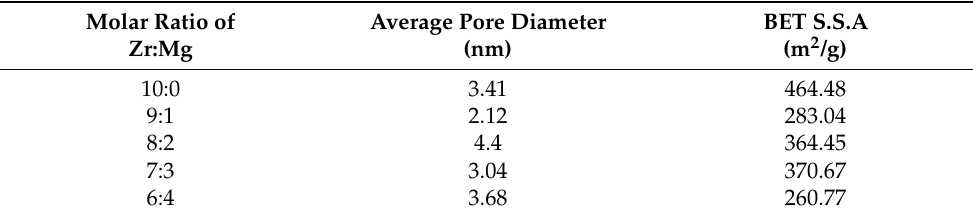
Table 1. The average pore diameter and specific surface area of the as-prepared Zr–Mg mixed oxide aerogels with different Zr/Mg molar ratios.